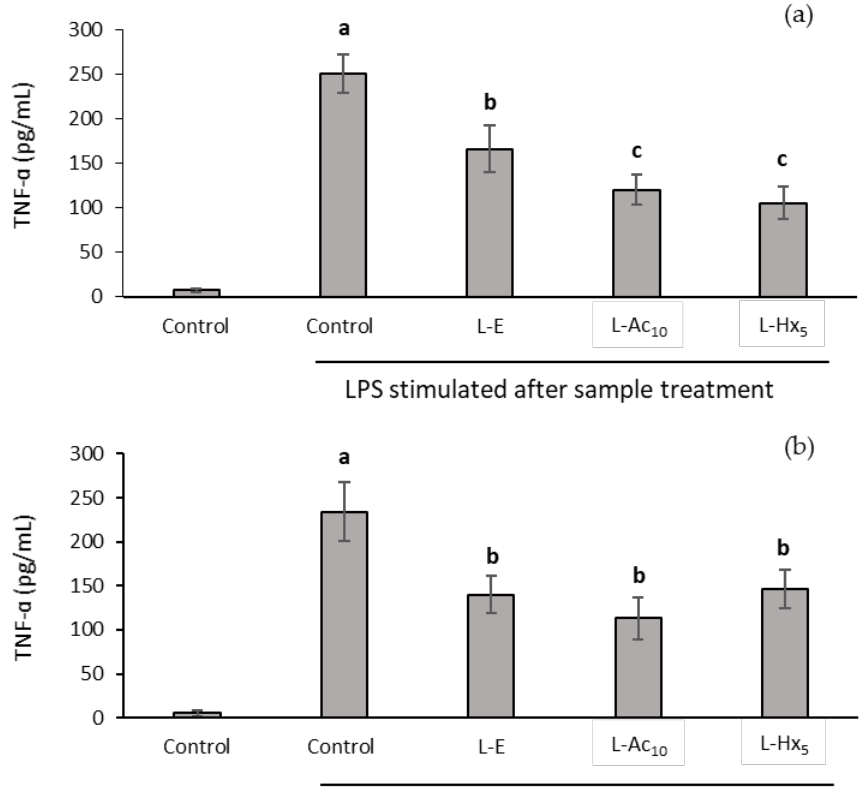
Figure 3. Effects of incubation with liposomes on TNF- α production in the THP-1 cells differentiated to macrophages. Cells were treated with LPS after ( a ) and before ( b ) the samples were incorporated. Data are expressed as mean ± S.D. ( n = 6). Different letters (a,b,c) indicate significant differences ( p ≤ 0.05) by Tukey test.